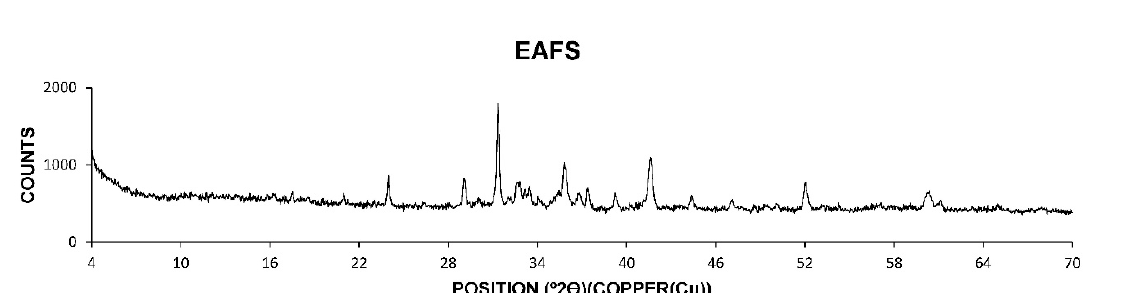
Figure 5. Results of X-ray diffraction of electric arc furnace slag.